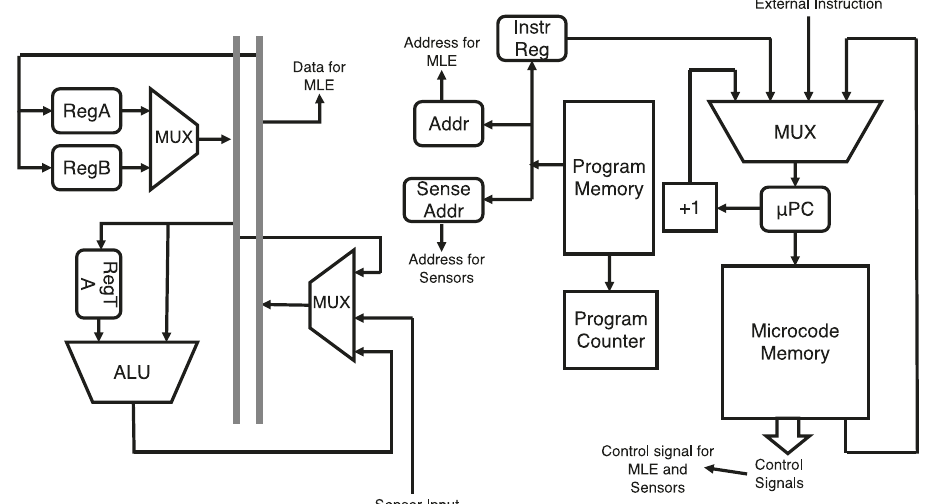
Fig. 5 | Order Code Processor (OCP). The components in OCP (digital SRI block) areshown.OCPsupports16differentinstructions.Therearethreeregisterseachof whichhasa5-bitwidth. The fi xedcode sitsintheprogrammememory whereeach